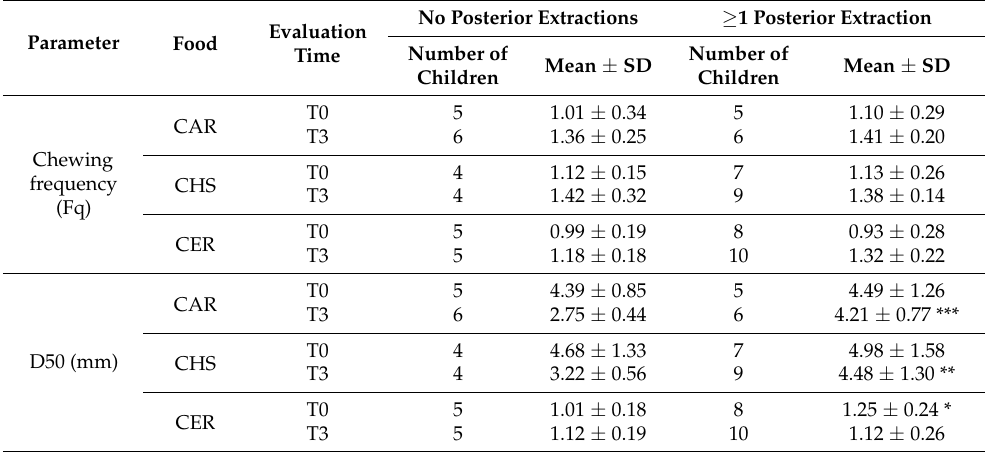
Table 5. Masticatory frequency and D50 values according to posterior teeth extractions in the Group with